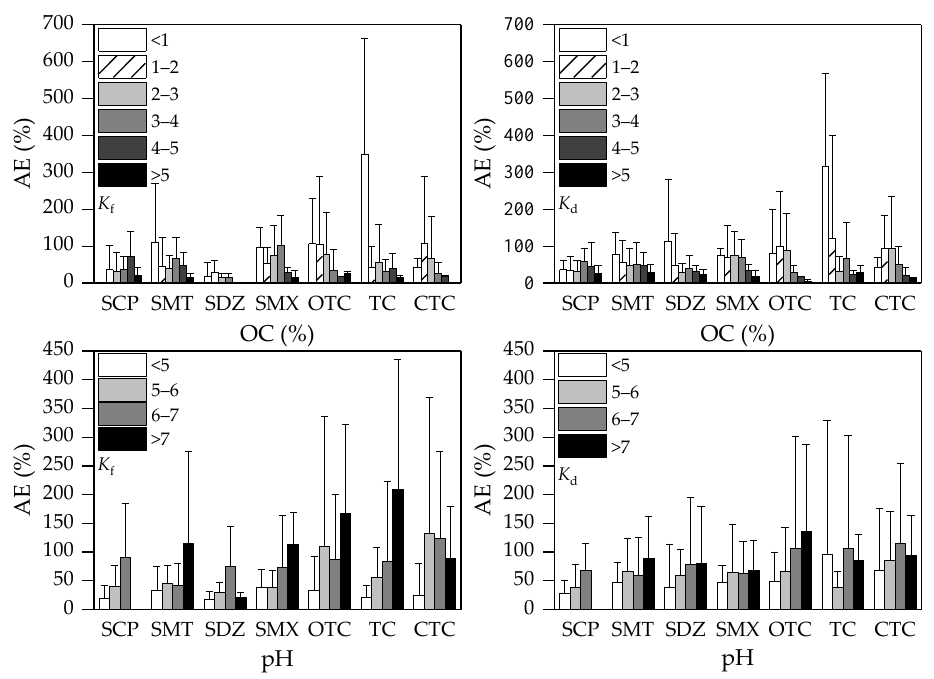
Figure 2. Absolute error (AE) distributions of K f and K d estimation across different OC and pH ranges in sub-datasets “A” and “B” using the pedotransfer equations given in Table 4.